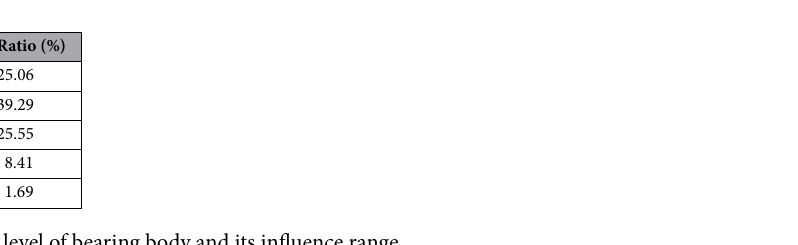
Table 4. Vulnerability level of bearing body and its influence